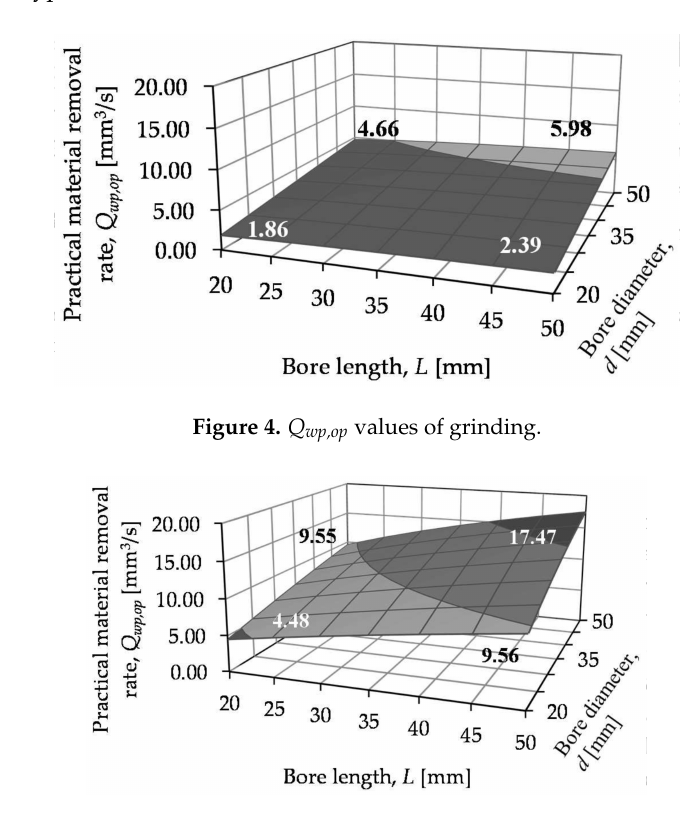
Figure 5. Q wp,op values of hard